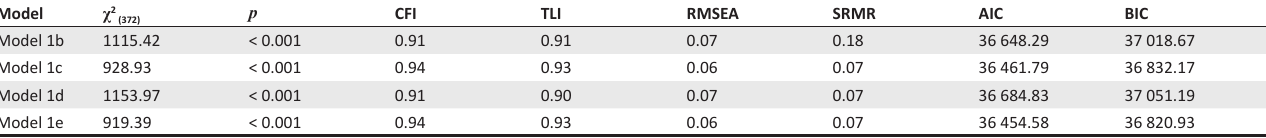
FIGURE 1 : Structural model of meaningful TABLE 5 : Fit statistics for the four competing structural models. Model χ 2 (372)